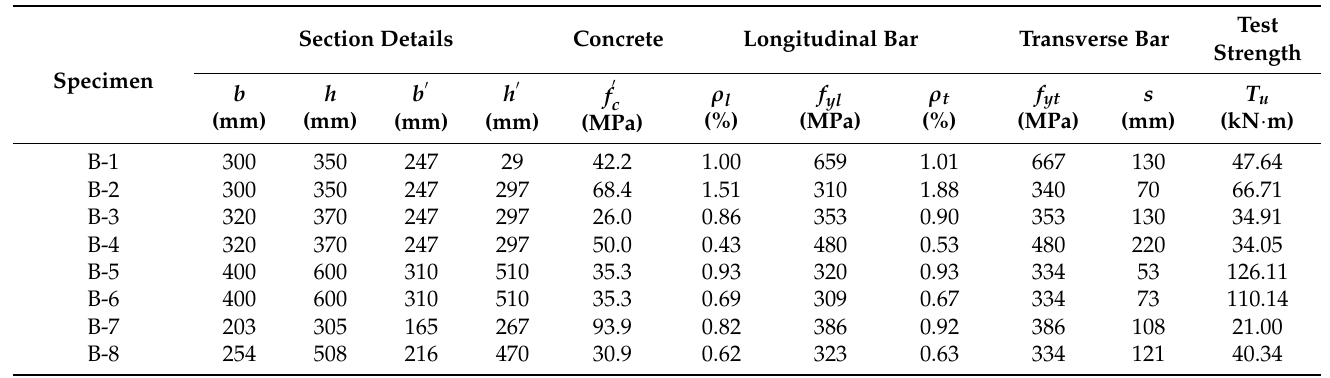
Table 3. Details of the validation set specimens.